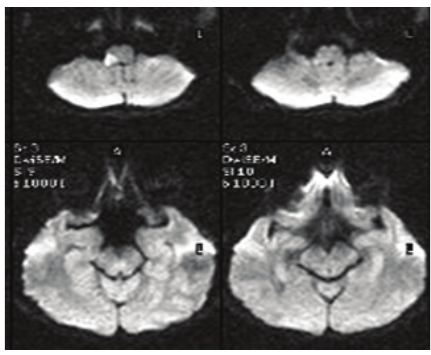
Figure 1: The diffusion restriction which led to the acute infarct, holding the posterolateral bulbus right hemisphere according to the results of the diffusion MRI.